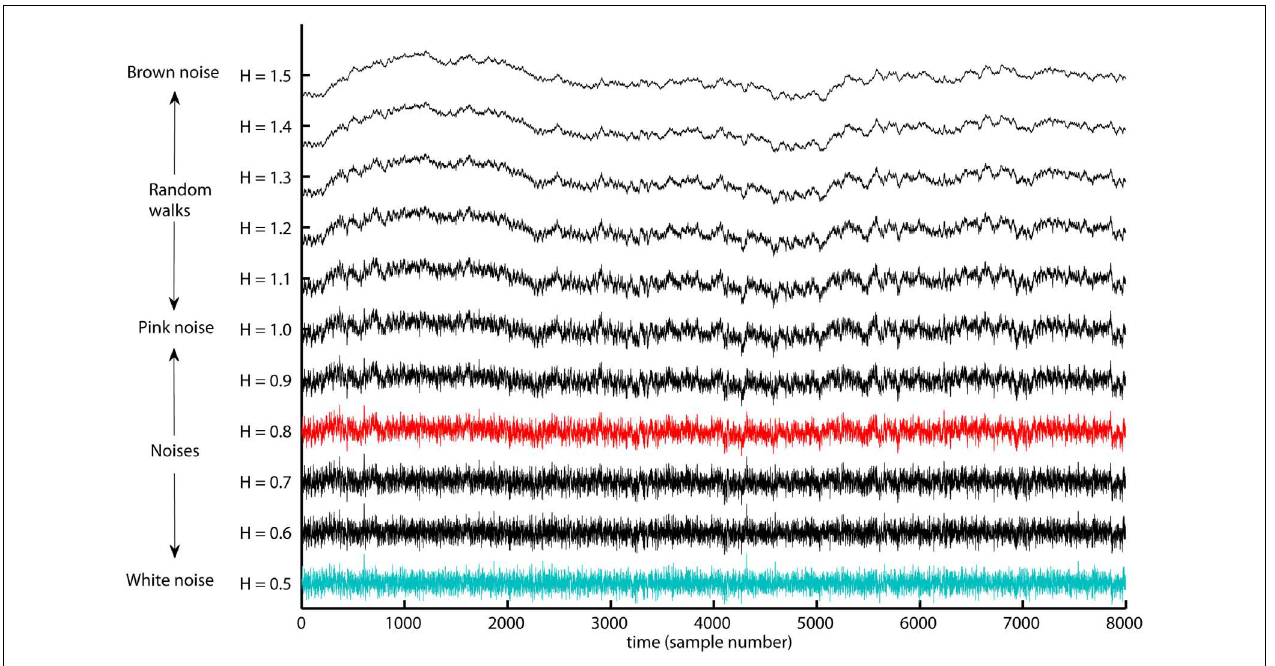
apparent slow evolving fluctuations.The examples monofractal ( red trace ) and whitenoise ( turquoise trace ) used in the present tutorial are both noise like time series.The long-range dependent structure of most biomedical signals is located within the illustrated continuum of fractal